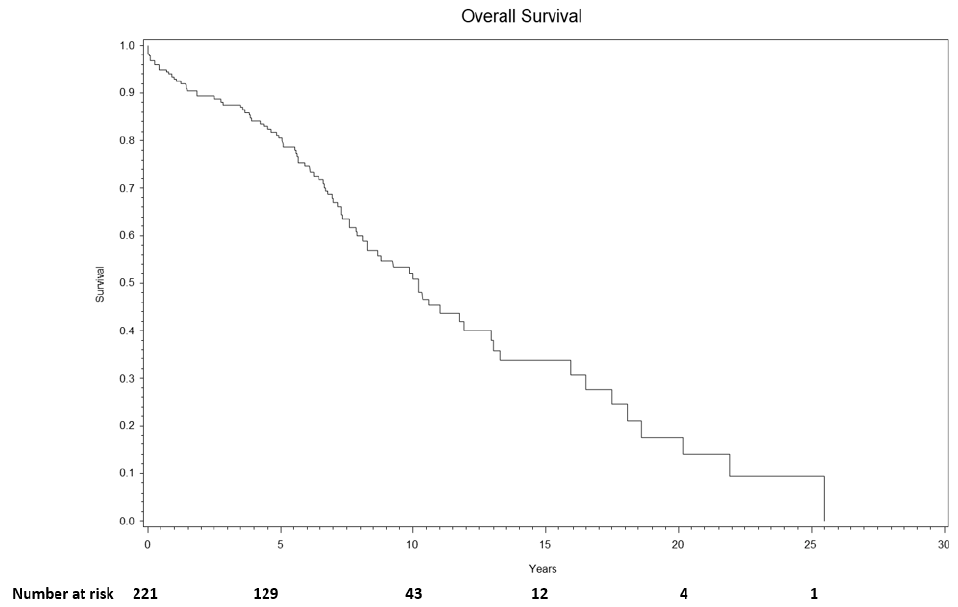
Figure 3. Overall survival following two-stage exchange at 1-year, 3-year, and 5-year was 93% (95% CI: 89–96%), 88% (95% CI: 82–91%), and 80% (95% CI: 74–86%), respectively.